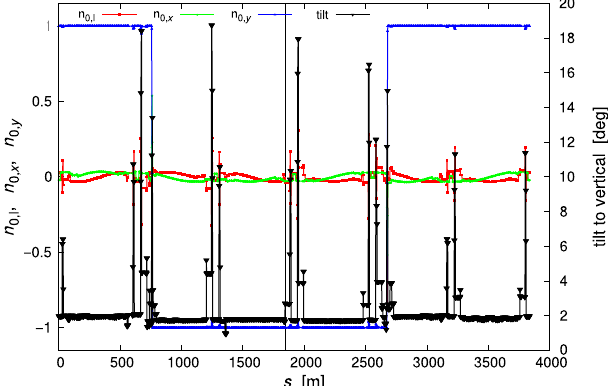
FIG. 17. Nominal RHIC Yellow ring settings, at store. The graph displays spin ⃗ n 0 components and tilt to vertical. The latter is about 2° around the ring, with up to 18° spikes at the fall or rise of the vertical orbit separation bumps. The vertical bar at s ¼ 1850 m materializes the location of the p-C polarimeter, 1846 m from IP6, CCW, ⃗ n 0 tilt to vertical there is ≈ 3 °. Snake field maps are used